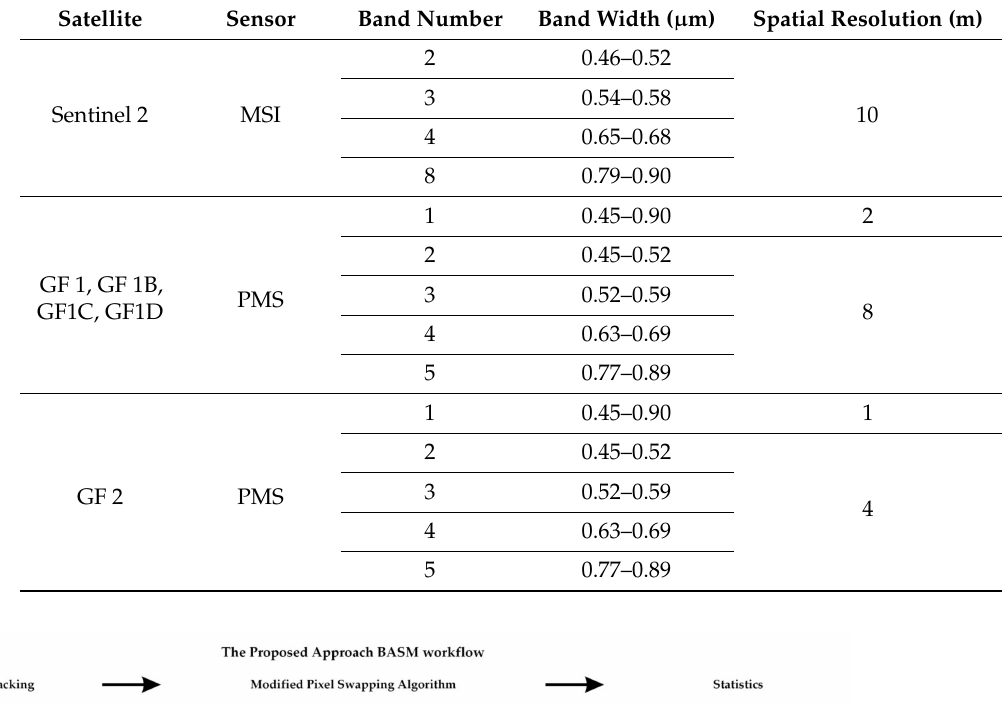
Table 2. Selected bands of Sentinel 2, GF 1, GF 1B, GF 1C, GF 1D, and GF 2 satellite imagery data sets used in the current study.